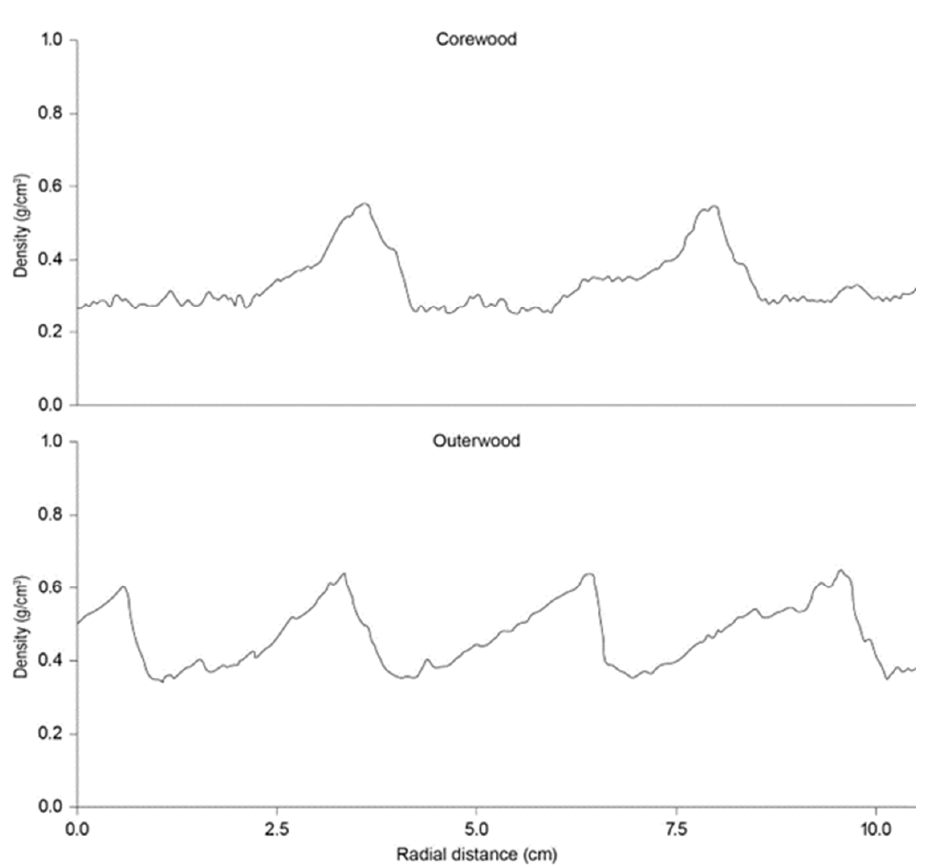
Figure 6. Densitometric traces showing within-ring progressions of wood density in (redrawn from Harris Figure 2 in [29]): Upper: P. radiata corewood, Lower: P. radiata outerwood.